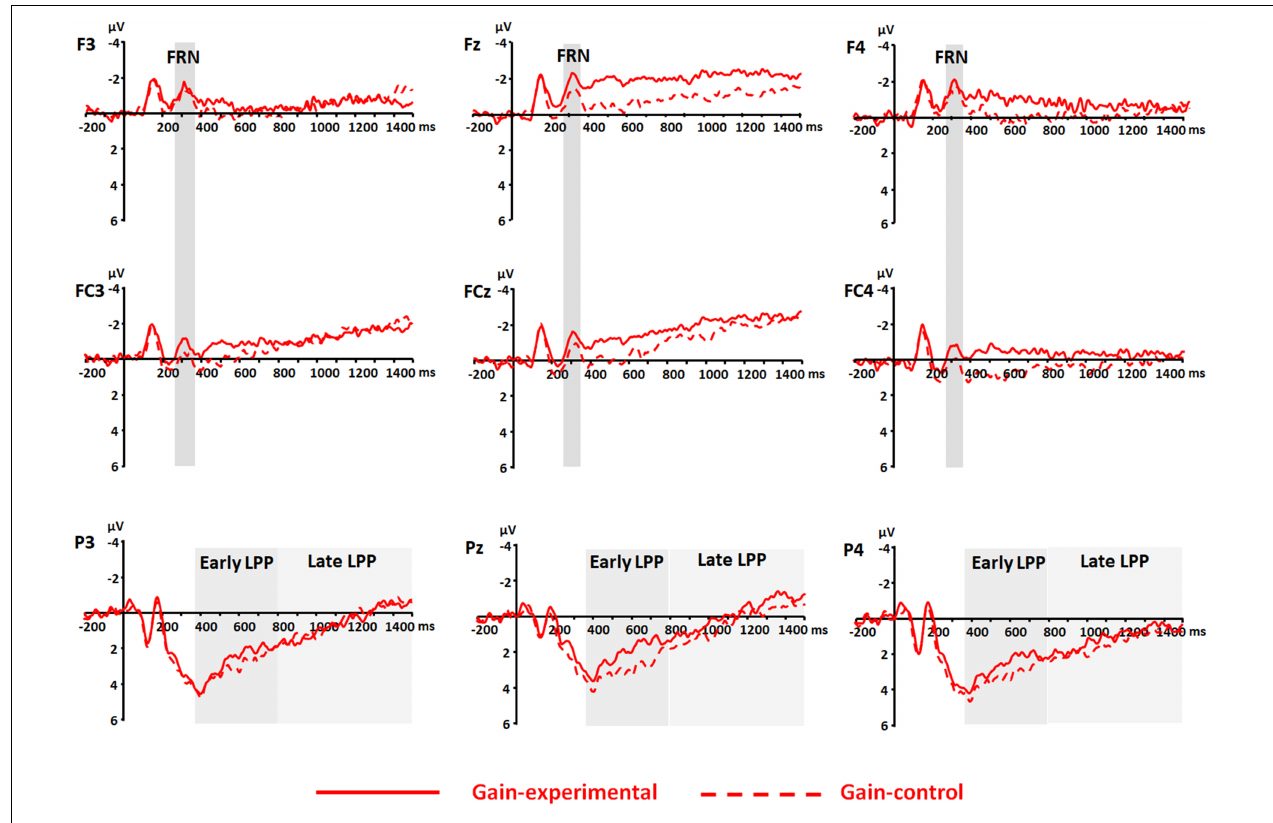
FIGURE 3 | Event-related potential (ERP) waveforms at frontal (i.e., F3, Fz, and F4), frontocentral (i.e., FC3, FCz, and FC4), and parietal (i.e., P3, Pz, and P4) electrodes for the experimental and control conditions in the gain frame. Shaded areas represent time windows for feedback-related negativity (FRN) (264–364 ms) and early and late positive potential (LPP) (364–800 ms and 800–1,500 ms, respectively). The presented waveforms were obtained by averaging the waveforms across trials ( means of trial numbers were 41.75 and 41.88 in the experimental and control conditions, respectively) and of 32 participants within the respective